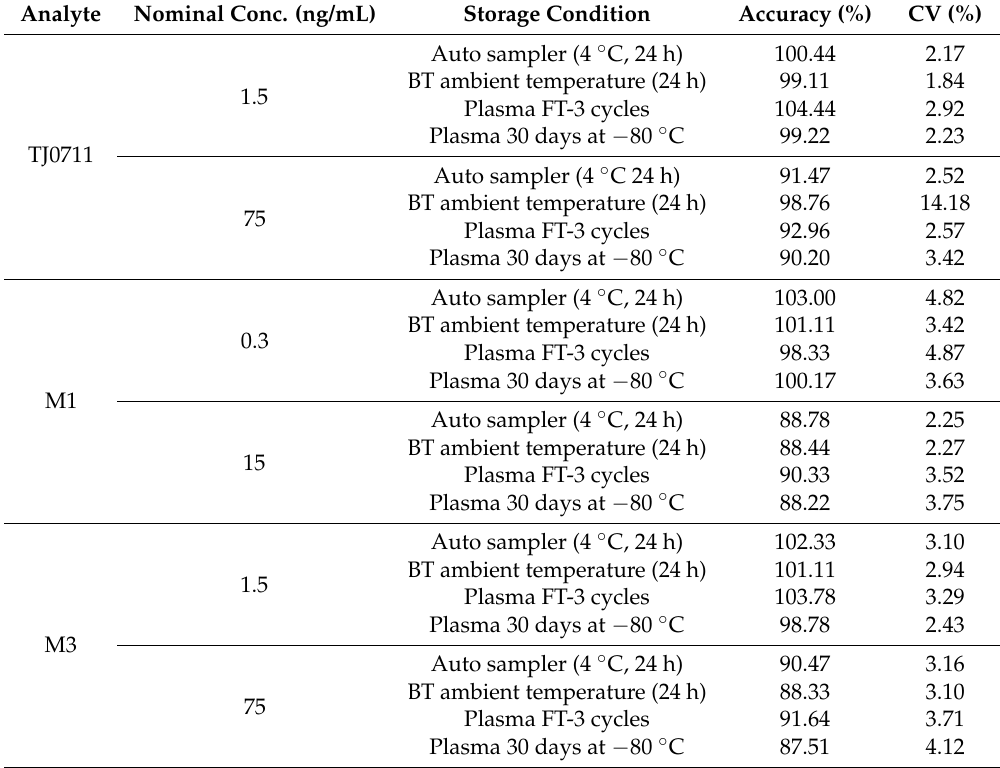
Table 4. Stability of TJ0711, M1, and M3 in dog plasma under various conditions ( n = 6).